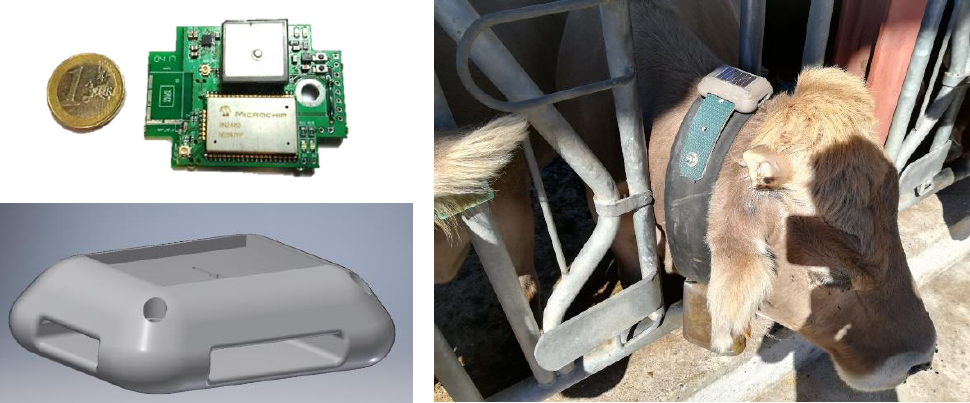
Figure 4. 3D and final prototype.